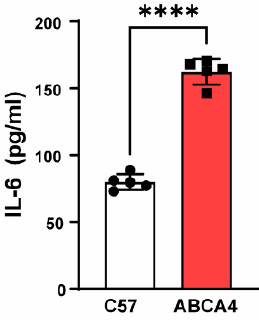
Figure 6. P2X7 preceptor-mediated IL-6 release increased in ABCA4 − / − RPE cells. Primary cultures of RPE cells from C57Bl6 and ABCA4 − / − mice were exposed to IL-6 for 1 h, after which the supernatant was collected and IL-6 levels determined. **** p < 0.0001, n = 5.